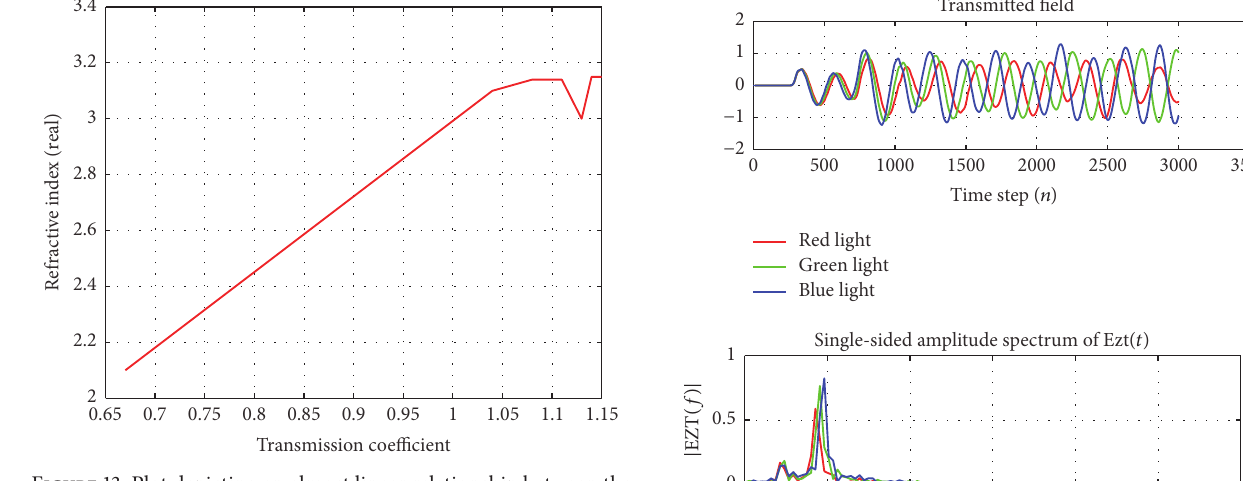
Figure 13: Plot depicting an almost linear relationship between the real component of refractive index and transmission coefficient for a radius ratio of 1.5.